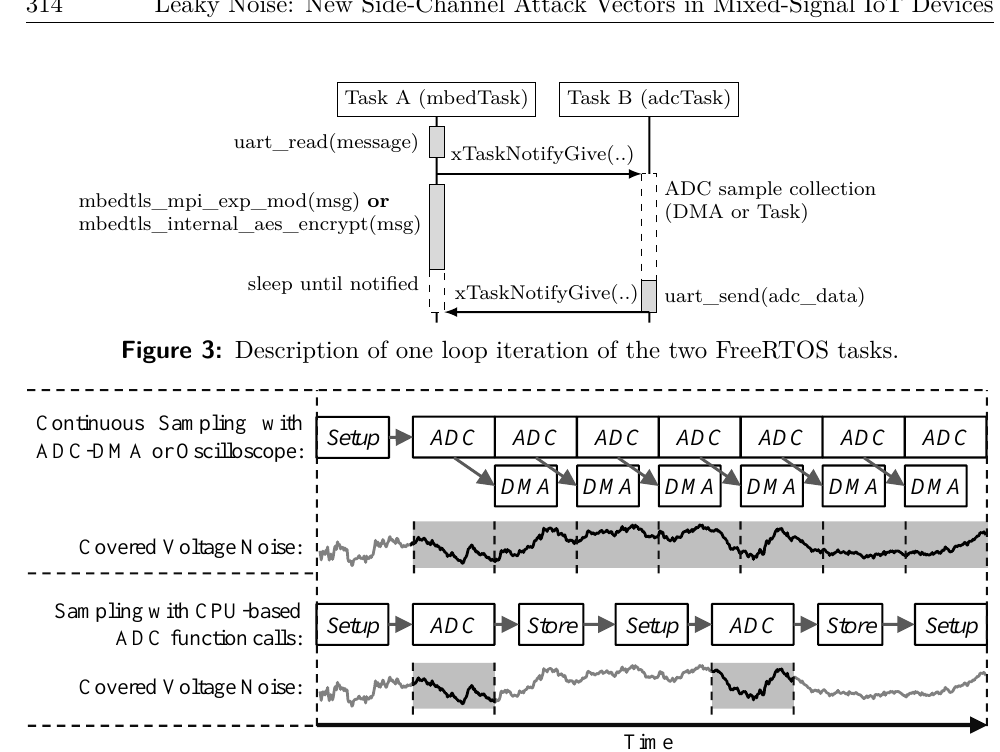
Figure 4: Principle how different ADC sampling styles will cover less or more parts of the voltage noise affecting the ADC result. DMA needs to be used for continuous sampling, while software-based sampling (in the multi-core scenario) will always introduce some